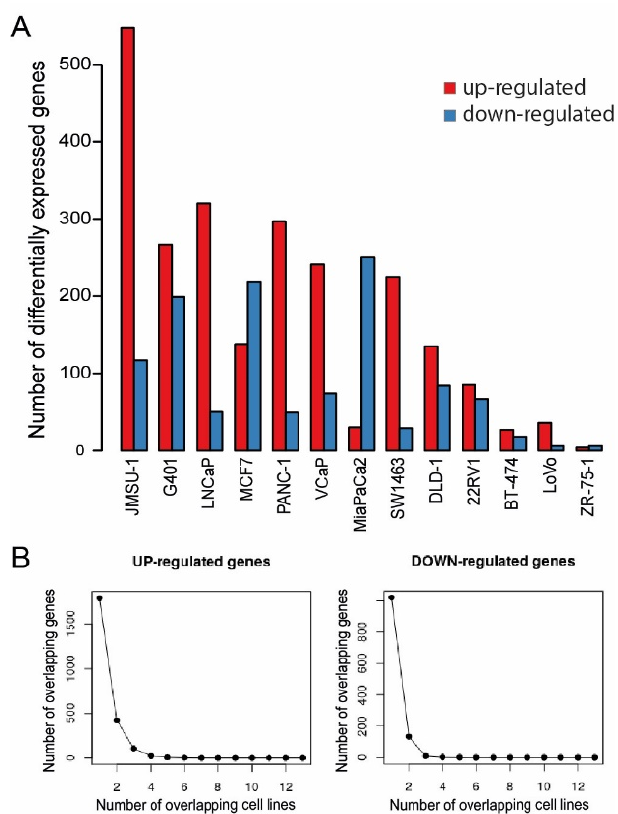
Figure 3. Differential gene expression effects of BAY-155 across several solid cancer cell models. ( A ) Number of genes up-regulated (red bars) and down-regulated (blue bars) upon treatment by BAY-155 in the indicated cell models (logFC > 1 or logFC < − 1 and FDR < 0.1). ( B ) Number of overlapping up-regulated ( left ) or down-regulated ( right ) genes in cell lines treated with BAY-155. To evaluate a general overarching role of menin in transcriptional regulation, which has been for instance reported for the Hox gene cluster [30], we assessed the overlap between di ff erentially expressed genes in di ff erent cell lines (Figure 3B). We observed a significant drop in the number of overlapping up-regulated or down-regulated genes, when 2 cell line models were compared. No overlap was observed when four (Figure 3B left for up-regulated genes) or three (Figure 3B right for down-regulated genes) cell models were compared. Altogether, these data suggest that inhibiting the interaction of menin with MLL1 with BAY-155 leads to a cell line-specific response at the gene expression level. We could not observe any evidence of an overarching, menin-driven expression program, which is in contrast to previous reports for e.g., the Hox gene cluster in mice